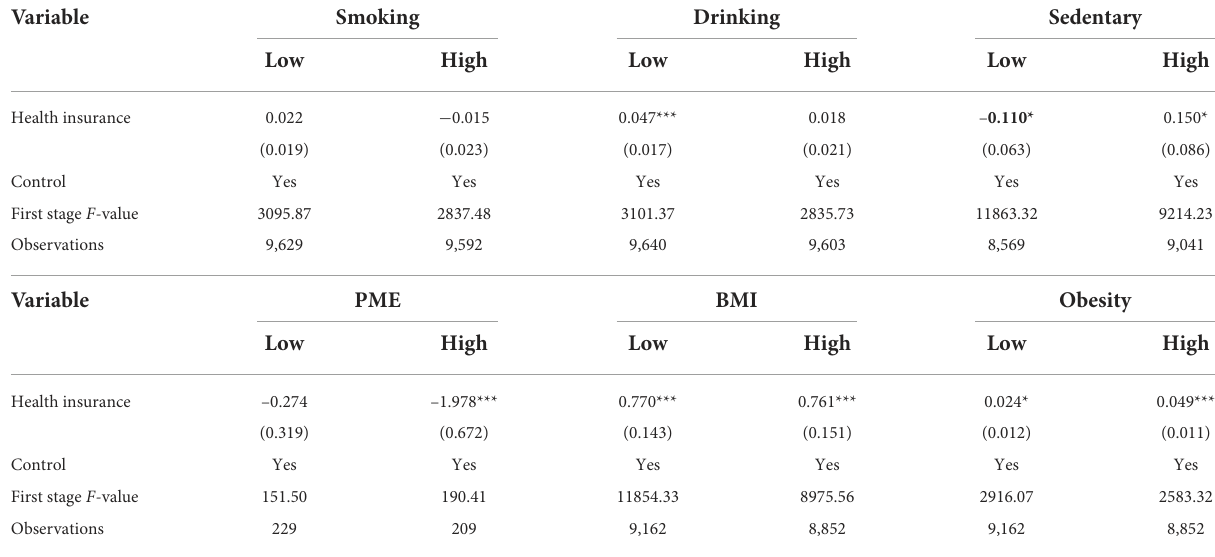
TABLE 7 Heterogeneity by educational